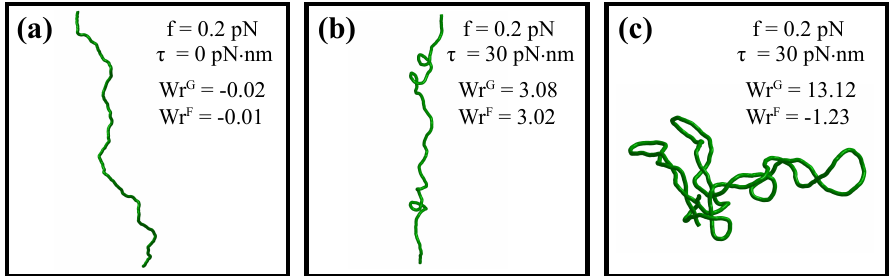
Figure 3. Examples of DNA equilibrium conformations obtained by the Metropolis-Monte Carlo algorithm. In the absence of torque, mechanically-stretched DNA typically assumes an extended chain configuration ( a ). On the other hand, the application of sufficiently large positive or negative torque leads to the DNA buckling transition ( b ), which eventually results in the formation of supercoiled DNA plectoneme structures ( c ). Evaluation of the DNA writhe number by the Gauss double contour integral (Wr G ) and Fuller’s formula (Wr F ) shows that both formulas predict very similar values of the DNA writhe number up to the onset of the DNA buckling transition. For plectonemic DNA structures, however, Fuller’s formula does not provide accurate estimations. In the above simulations, the length of DNA was set to 0.85 µ